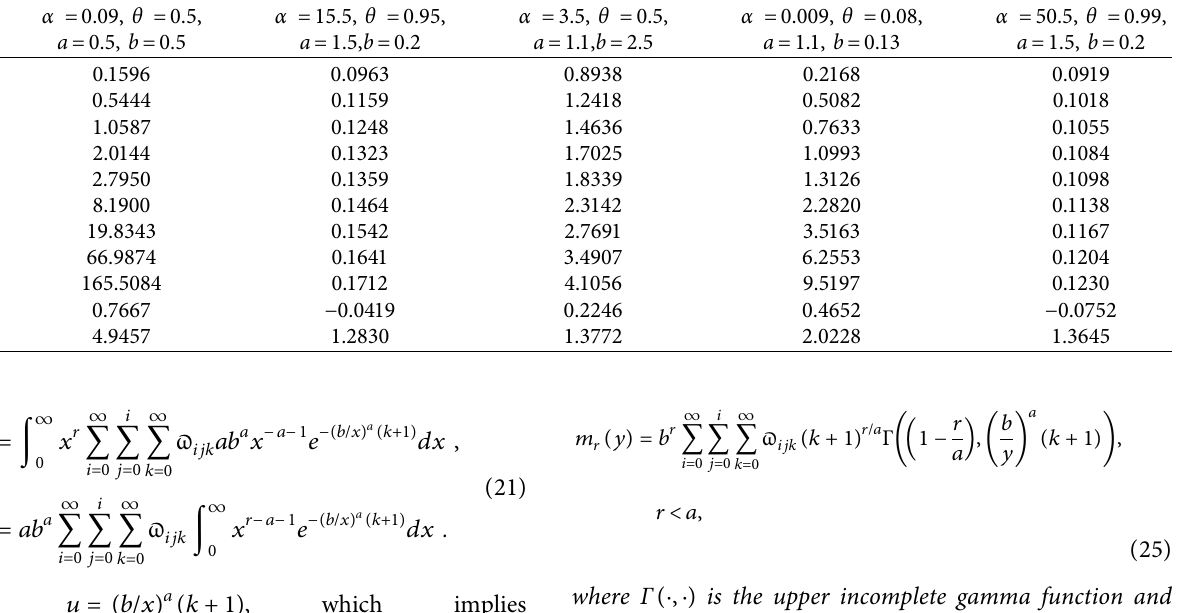
Table 1: HMF quantiles for some parameter